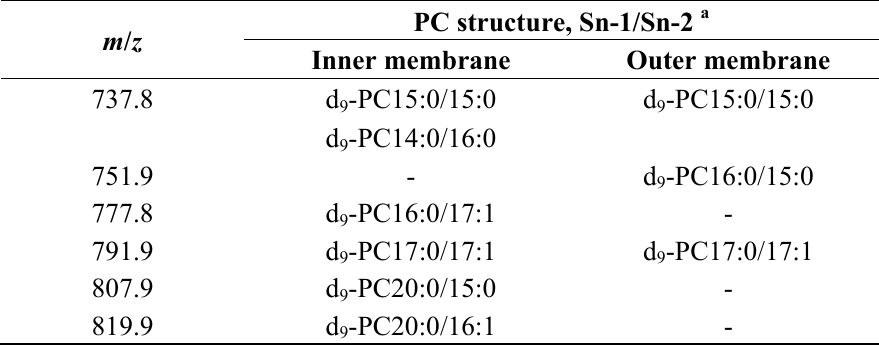
Table 1. The major d -labeled phosphatidycholine (PC) species determined by Liquid 9 Chromatography Coupled with the Mass Spectrometry Technique Using the Electrospray Ionization Technique (LC/ESI-MS) in the inner and outer membrane of L. dumoffii